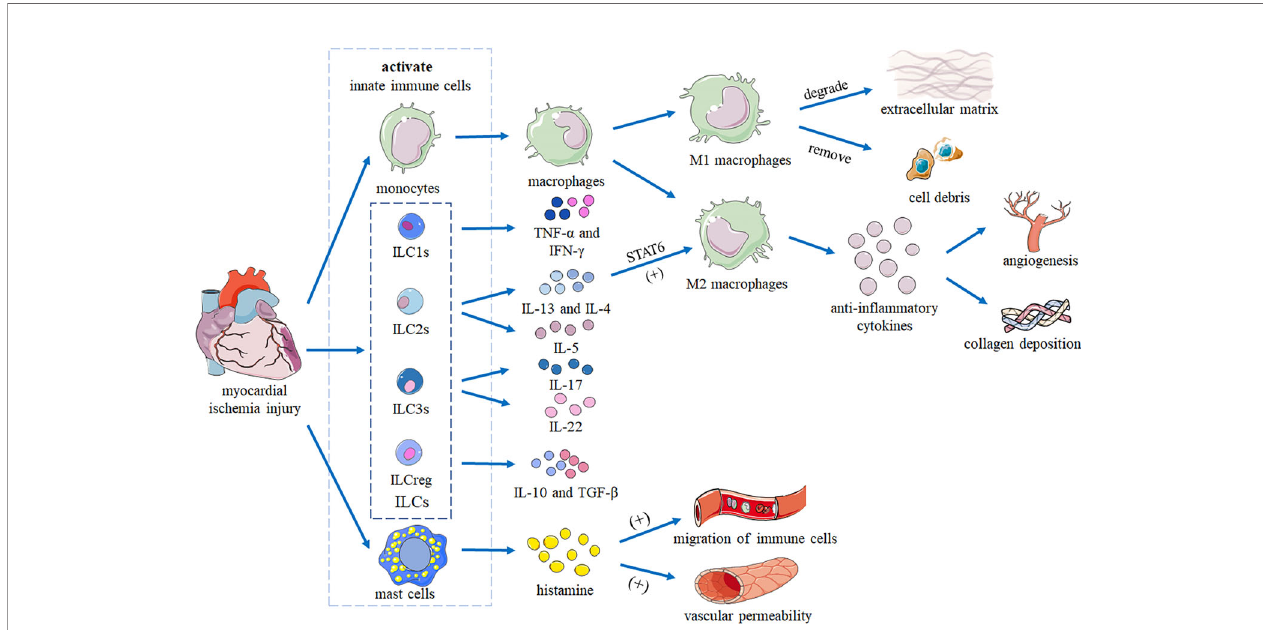
FIGURE 1 | Heart repair by innate immune cells following myocardial ischemia injury. After myocardial ischemic injury, innate immune cells residing in the myocardium are immediately activated. Monocytes in fi ltrate the injury site and differentiate into macrophages. M1 macrophages are responsible for degrading the extracellular matrix and removing cell debris. M2 macrophages secrete anti-in fl ammatory cytokines to promote angiogenesis and collagen deposition. IL-13 and IL-4 produced by ILCs promote polarization of macrophages into the M2 phenotype by activating STAT6. Mast cells release histamine to trigger vascular permeability and migration of innate immune cells. Together, these cells coordinate removal of damaged cells, remodeling of the tissue matrix, and recruitment of additional immune cells from the blood to promote recovery of cardiac